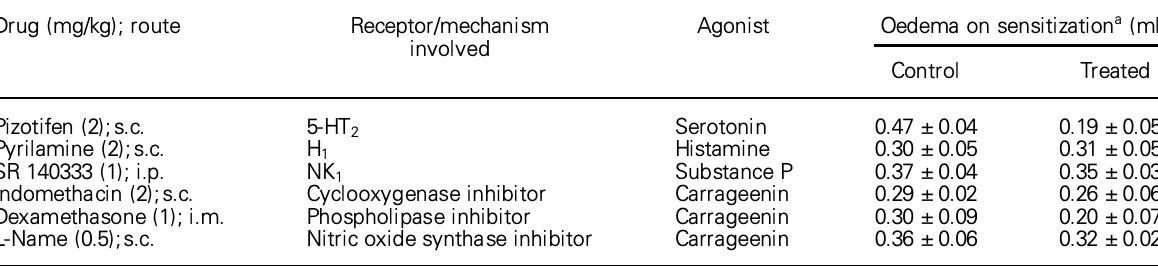
Table 1. Anti-oedematogenic effect of known inhibitors of the syntesis of inflammatory mediators and antagonists on the oedema induced by SEA following sensitization of rat paws Drug (mg/kg); route